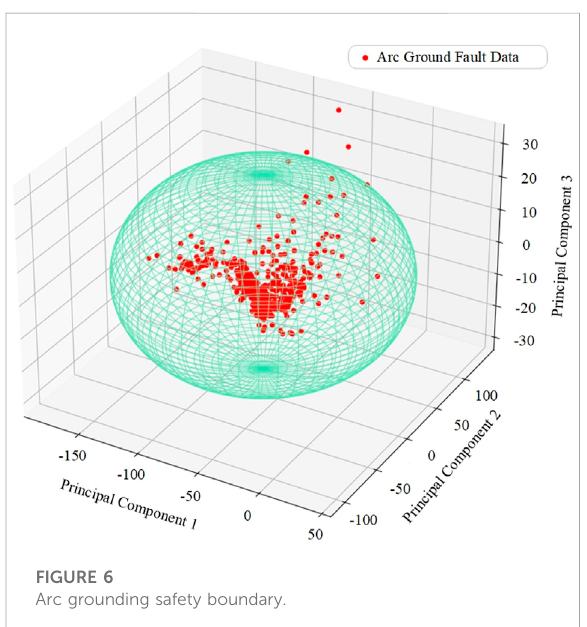
FIGURE 6 Arc grounding safety